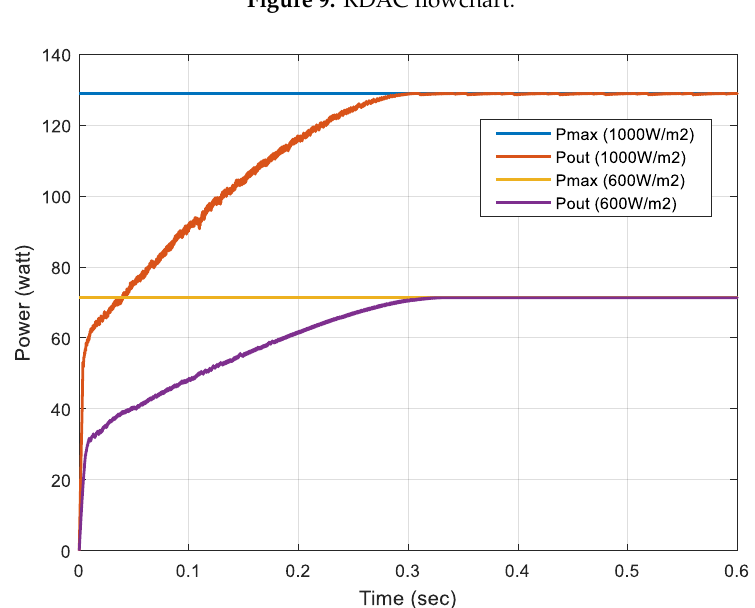
Energies 2019 , 12 , x FOR PEER REVIEW